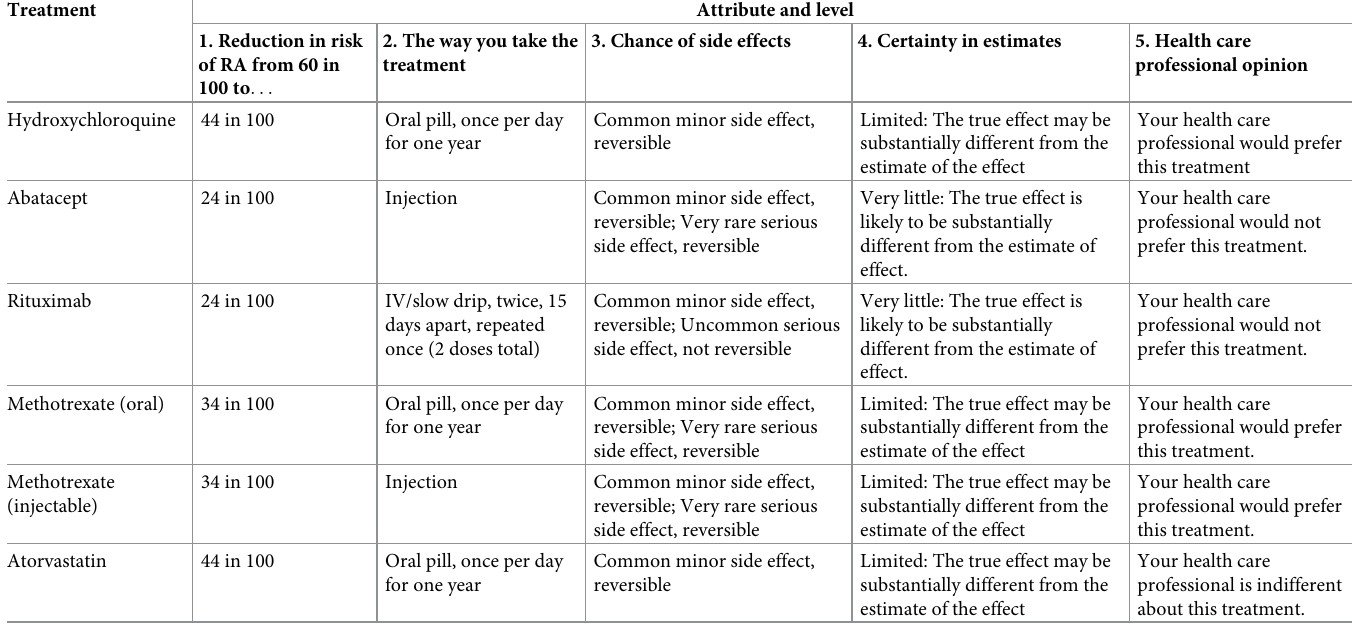
Table 2. Attributes and levels assigned to preventive treatments currently under study. Treatment Attribute and